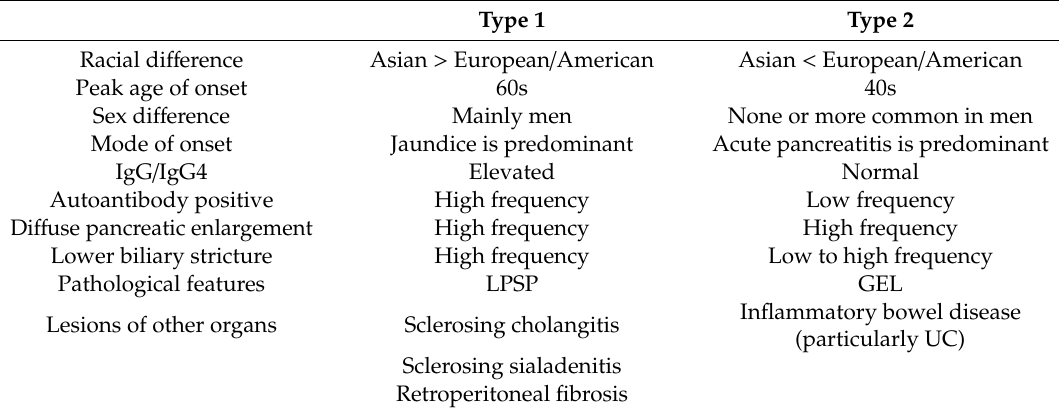
Table 2. Clinicopathological characteristics in type 1 and 2 autoimmune